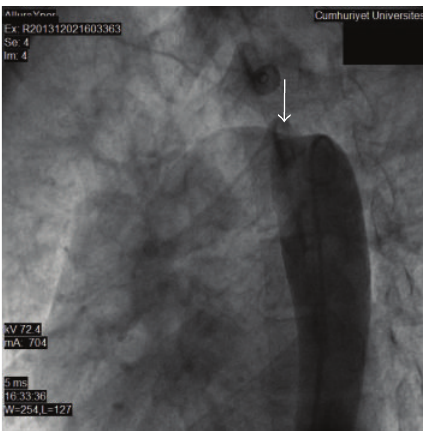
Figure 5: Postdilatation of thoracic stent graft.